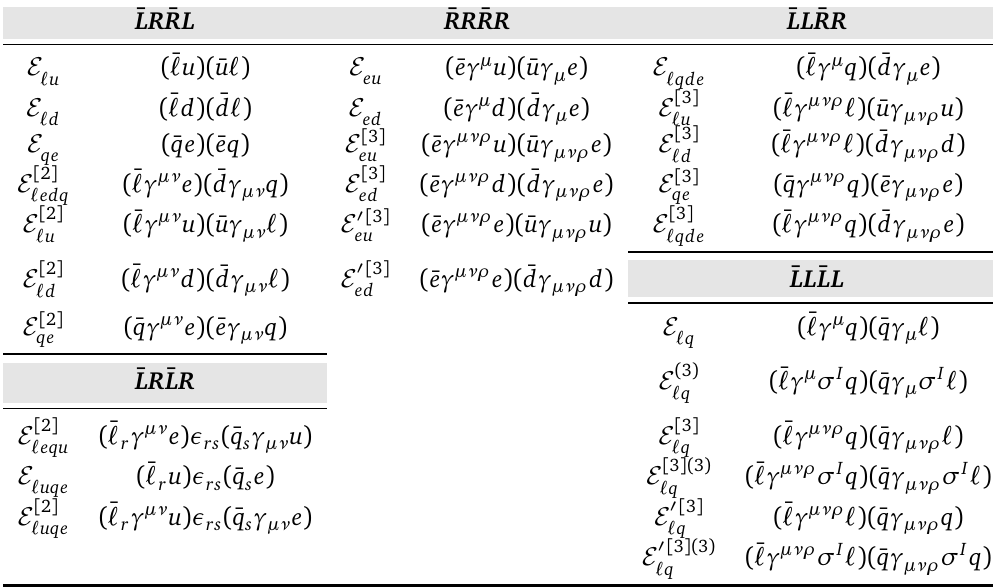
Table 6: Semileptonic four-fermion evanescent operators. We use the shorthand notation γ µ 1 ... µ n ≡ γ µ 1 ... γ µ n with no (anti)symmetrization.